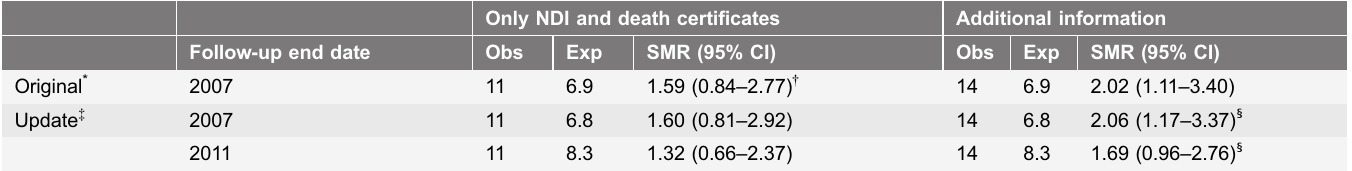
Table 3. Observed (Obs) and expected (Exp) number of malignant primary brain cancer deaths, standardized mortality ratio (SMR), and 95% confidence interval (95% CI) in original study (Alexander et al.) and current update, relying only on NDI and death certificates for cause of death information or relying on additional information not included on death certificates, as computed for follow-up through 2007 or